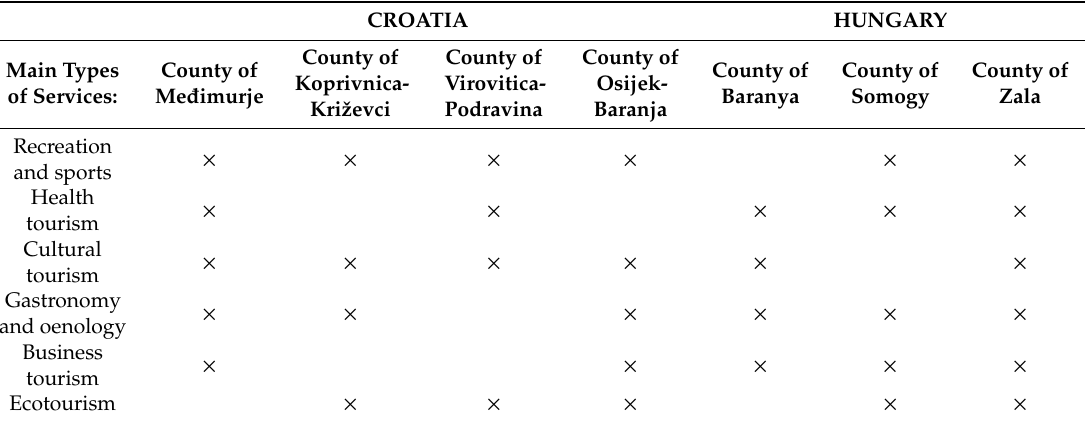
Table 3. Services o ff ered in the cross-border